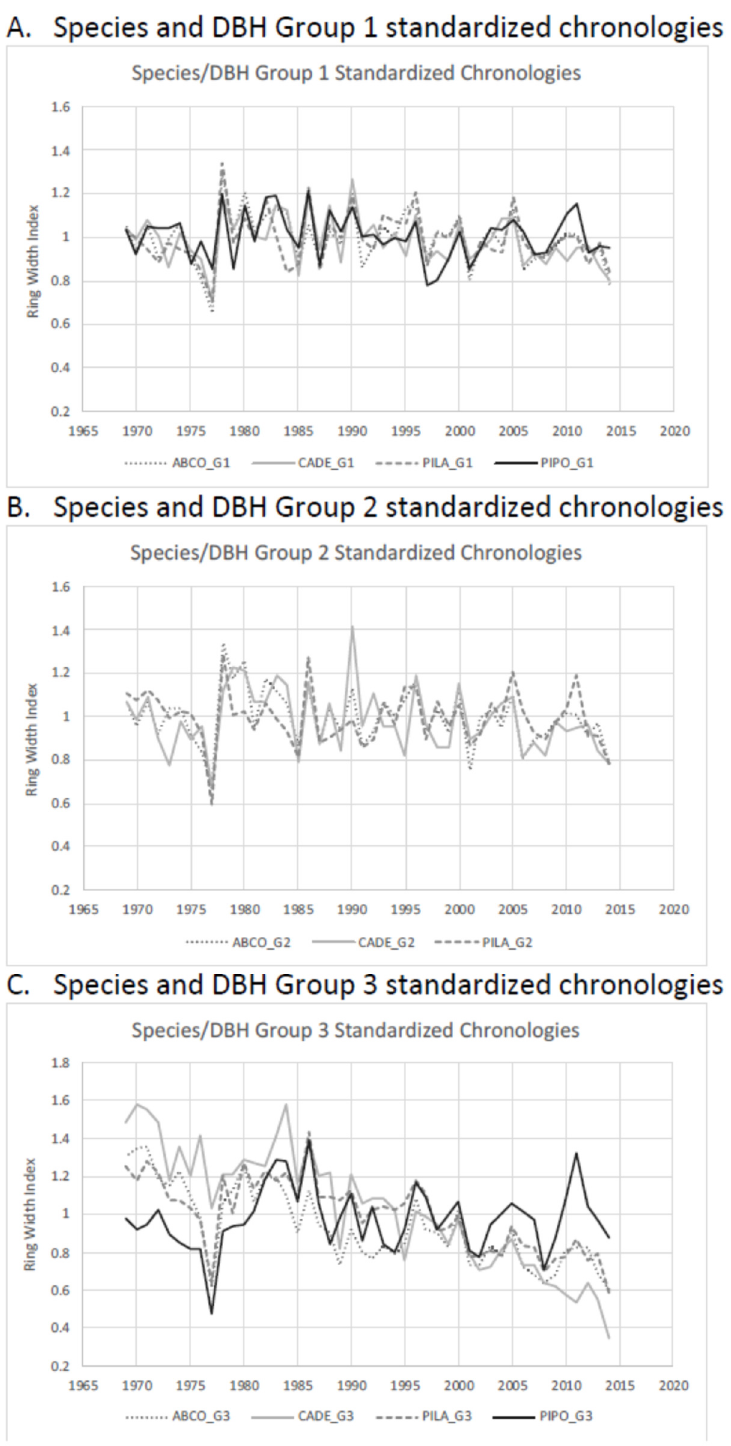
Figure 3. Standardized chronologies for the time frame of the dendroclimatological analysis